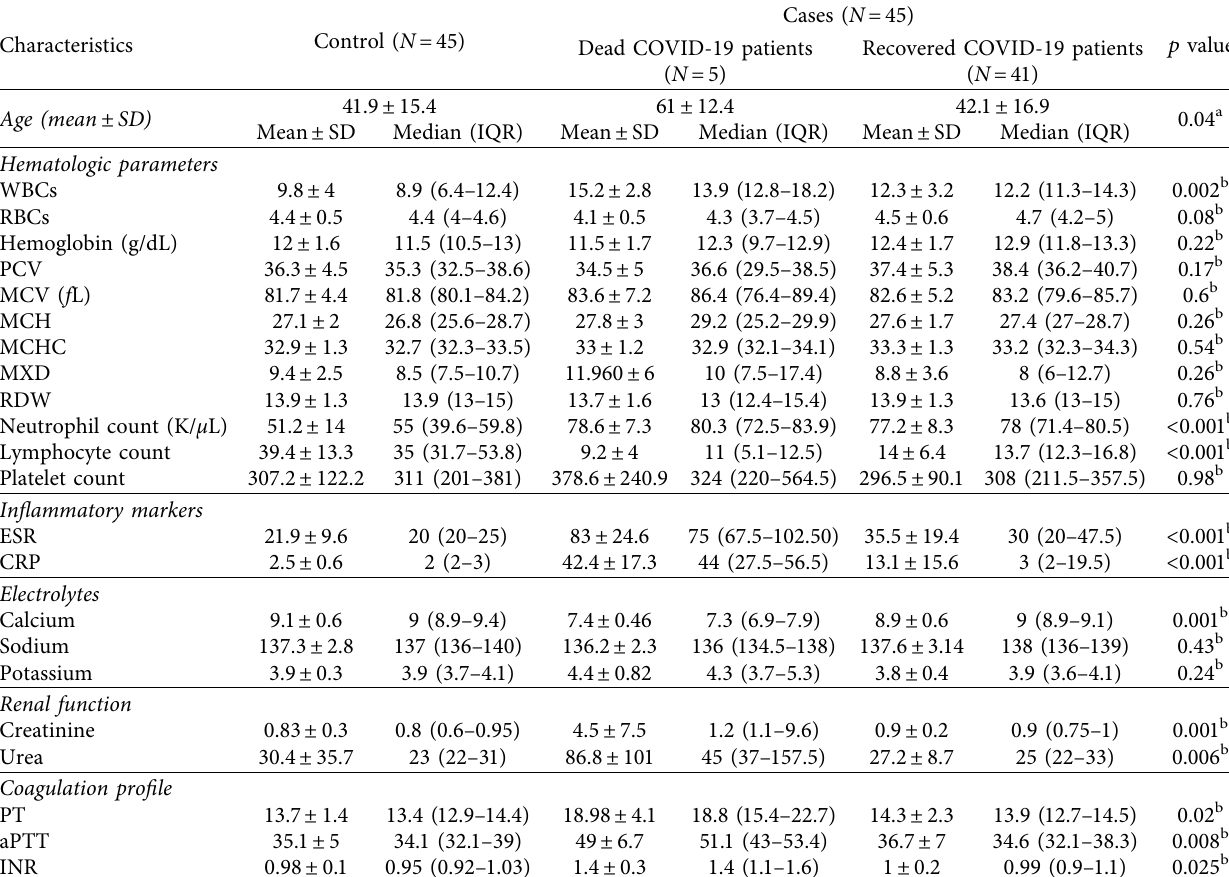
Table 2: Laboratory measurements of participants in cases and control